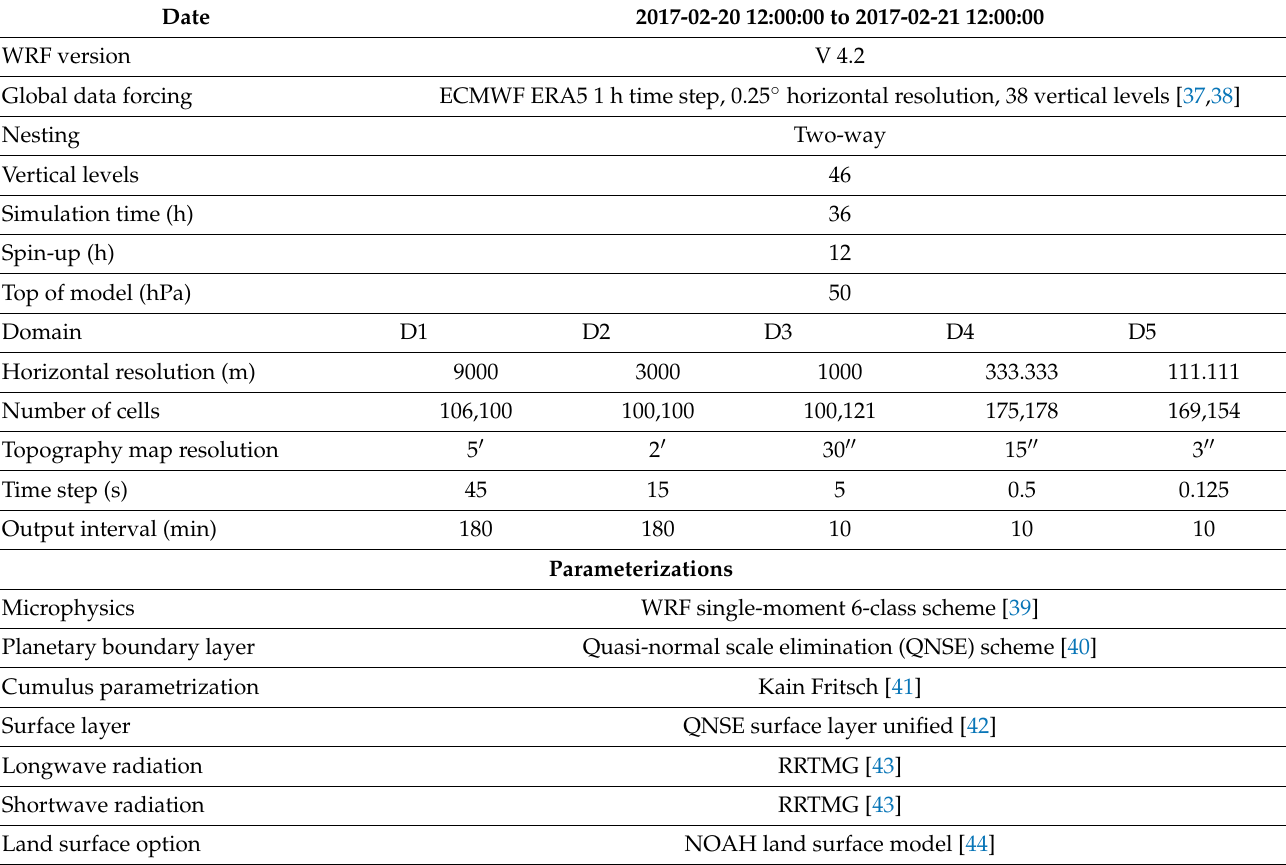
Table 1. Summary of the WRF domain and parameterization settings used for the